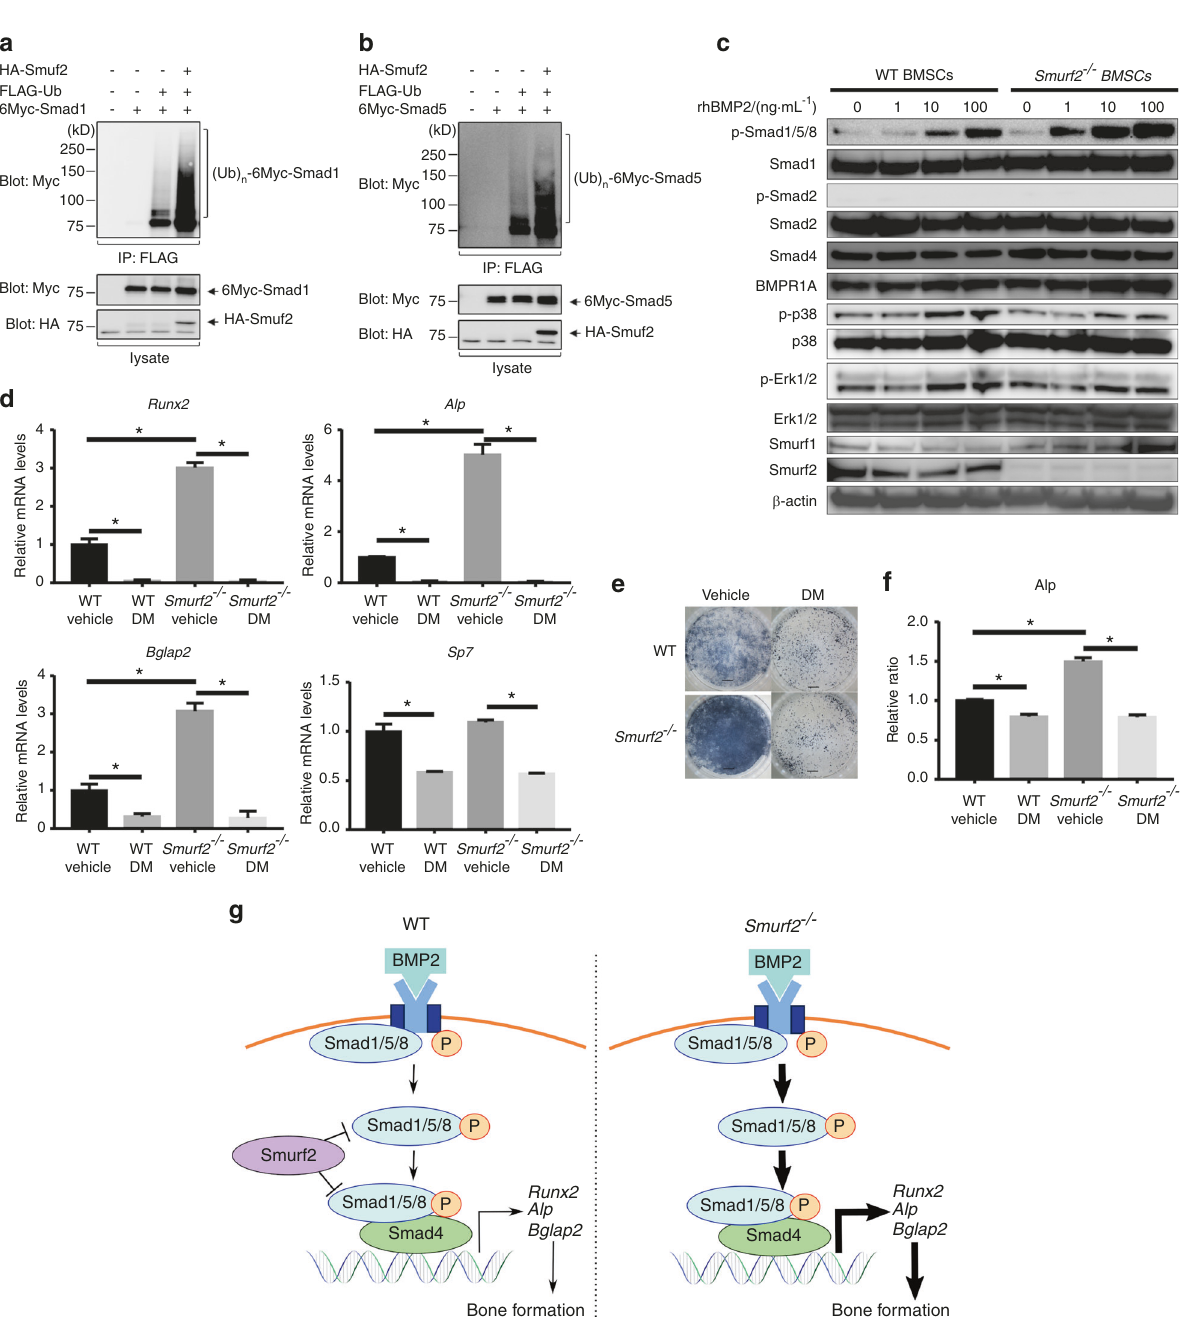
Fig. 6 Effect of Smurf2 on BMP/Smad signaling. a , b Ubiquitination assay of Smad1 and Smad5 ubiquitination by Smurf2. c Western blot analysis with the indicated antibodies to evaluate expression levels in rhBMP2-stimulated BMSCs. d Quantitative real-time PCR analysis of BMSCs cultured in rhBMP2-supplemented osteogenic medium containing DMSO (Vehicle) or dorsomorphin (DM, 4 μ mol·L − 1 ). e , f ALP staining of BMSCs cultured in rhBMP2-supplemented osteogenic medium containing DMSO (Vehicle) or dorsomorphin (DM, 4 μ mol·L − 1 ) (scale bar = 2 mm). g Model of the BMP/Smad pathway in WT and Smurf2 − / − mice. ( n = 3 mice per group; * P < 0.05 by one-way ANOVA followed by the Bonferroni the in vitro osteogenic differentiation assay were similar to those might have been caused by differences in osteoblastic bone of rhBMP2-induced ectopic bone formation in Smurf2 − / − mice. formation activity. The in vitro osteogenic differentiation assay revealed that the acute osteogenic differentiation process BMP has been reported to affect osteoclastogenesis indirectly and involving BMP/Smad signaling in Smurf2 − / − mice was enhanced directly as well as exert osteoinductive effects on bone formation. 20,21 In by supplementation with rhBMP2. However, the in vivo skeletal this study, rhBMP2-induced ectopic bone in Smurf2 − / − mice exhibited bone phenotype in Smurf2 − / − mice represents a state of increases in the TRAP-positive area and number of osteoclasts. In vitro, Smurf2 − / − BMSCs showed enhanced Rankl expression when cultured homeostasis in which a feedback or crosstalk mechanism can function to stabilize bone metabolism. Therefore, the conditions of in rhBMP2-supplemented medium. In contrast, in the osteoclastic